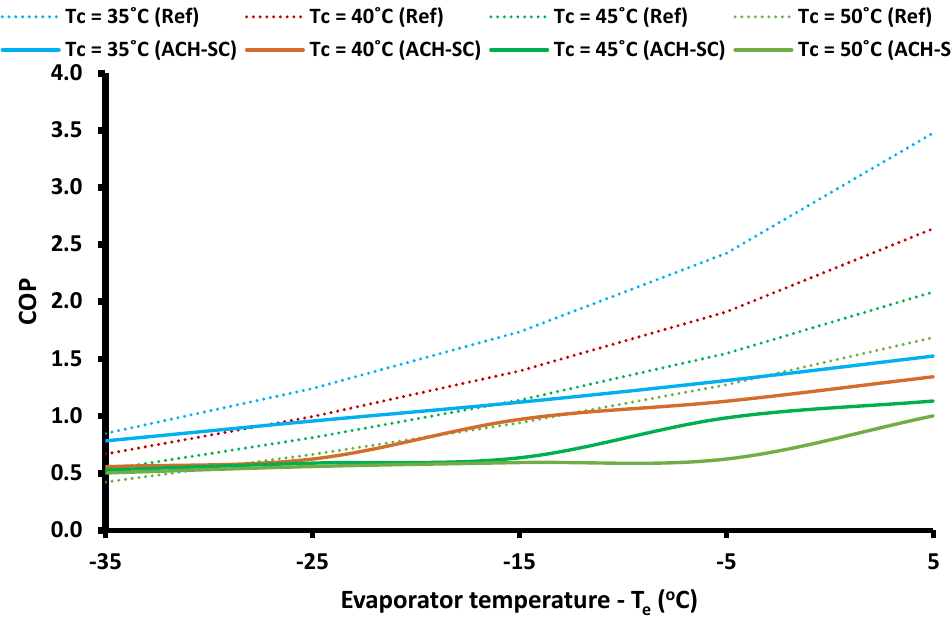
Figure 12. The COP of the absorption chiller subcooling system compared to the reference case for all the examined optimized scenarios.